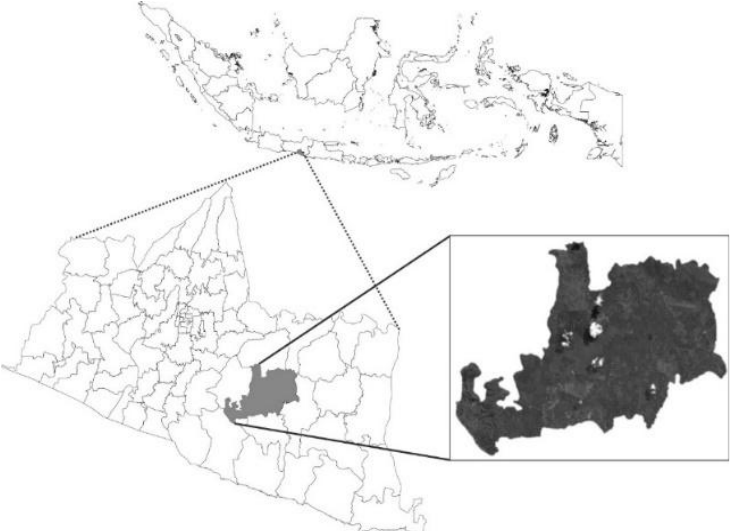
Figure 1. Geographical locations of the experimental site (latitude 7°52 ′ 59.5992 ″ S to 7°59 ′ 41.1288 ″ S and longitude 110°26 ′ 21.462 ″ E to 110° 35 ′ 7.4868 ″ E).